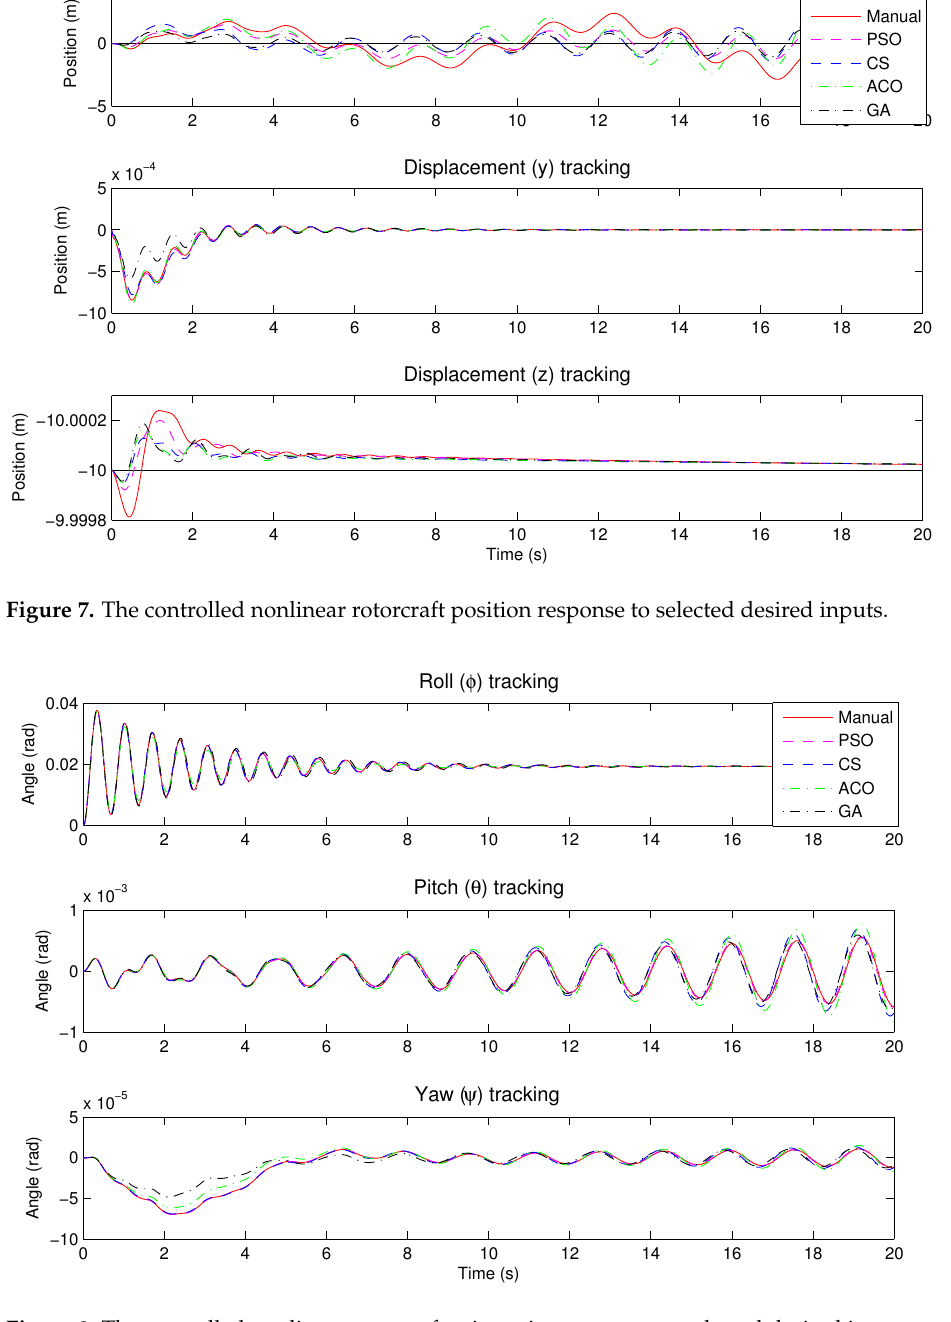
Figure 8. The controlled nonlinear rotorcraft orientation response to selected desired input. PID controllers tend to have better regulation than tracking due to the limited region of effectiveness. Next is the tracking of sudden changes in longitudinal displacement. The controllers are able to track a small forward speed up to 2 m/s (Figures 9 and 10). However, the ACO-PID seems to perform better. It also has less overshoot, which is very desirable if the rotorcraft is performing in confined spaces. The PSO-PID is the worst-performing, with a velocity overshoot of 68%. Figure 11 shows the inputs into the rotorcraft commanded by each controller. An attempt to move the rotorcraft from trim with a velocity higher than 2 m/s results in